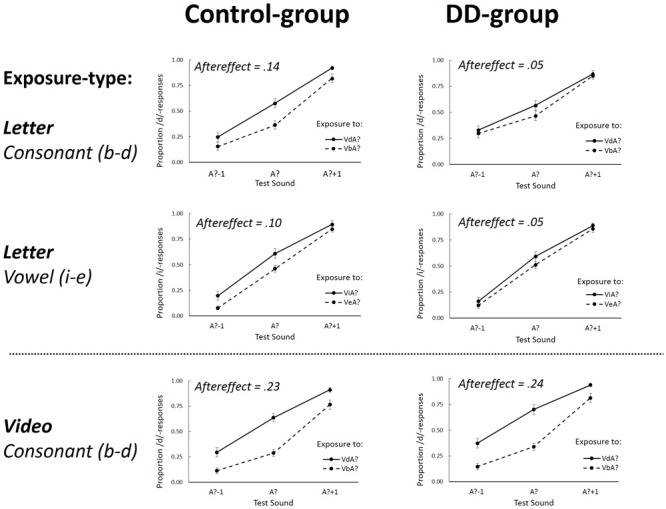
The proportion of /d/ (Experiment 1, Consonant) or /i/-responses (Experiment 2, Vowel) as a function of the three different Test-sounds (A?–1; A? and A?+1) after ambiguous Exposure-sounds. Graphs separately depict Letter (upper four graphs) and Video (lower two graphs) Exposure-types for the Control group (left graphs) and DD group (right graphs). Aftereffects represents the overall difference between the two Exposure-tokens (VdA? – VbA? for consonants, and ViA?–VeA? for vowels). Error bars represent the standard errors of the mean.